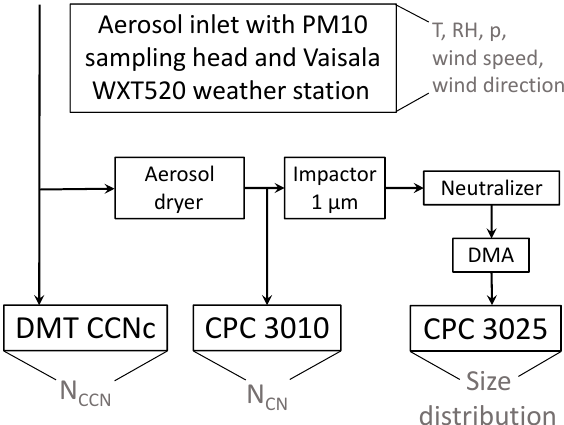
Figure 1. Schematic depiction of the measuring setup implemented in the Tuktoyaktuk ground-based (container)